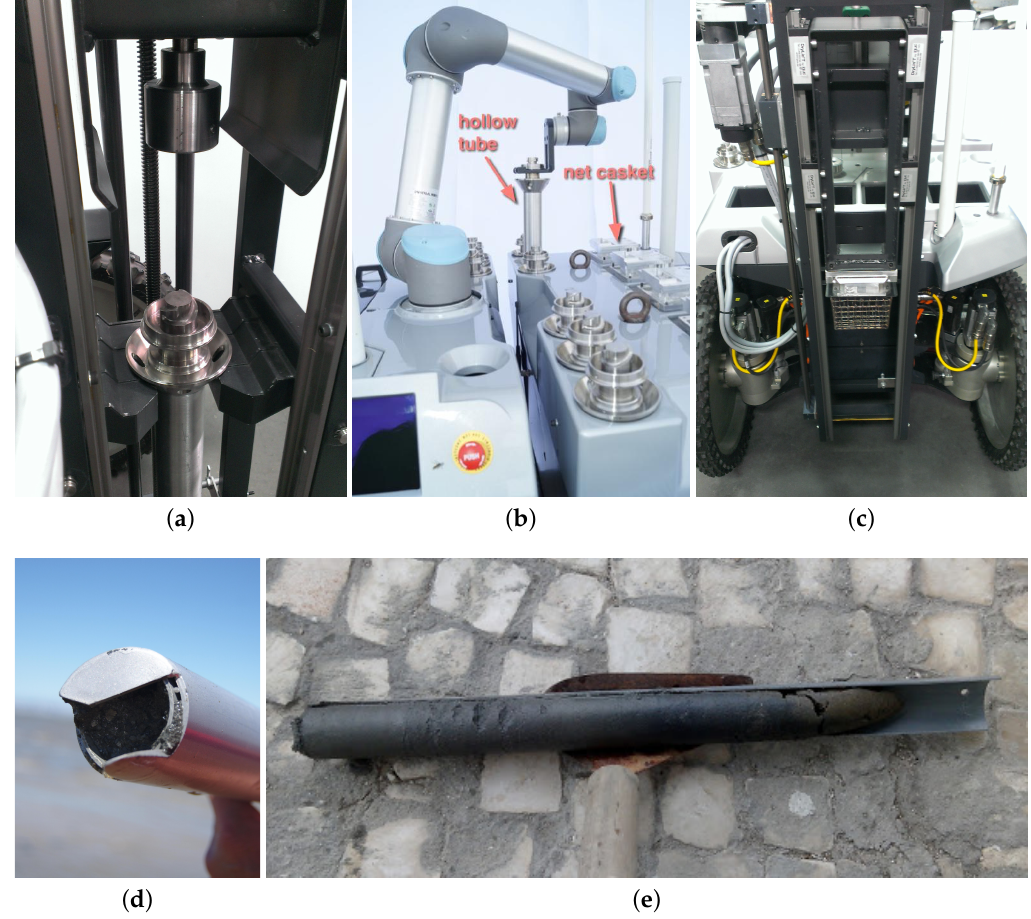
Figure 5. The drilling and dredging tools. ( a ) A hollow tube being attached to the drilling tool; ( b ) the robotic arm grasping a hollow tube to insert it into the drilling tool; ( c ) a dredger being pushed downwards by the dredging tool; ( d ) the hollow tube’s tip designed to prevent the core from slipping during extraction; ( e ) a sediment sample laid on the PVC half-tube after